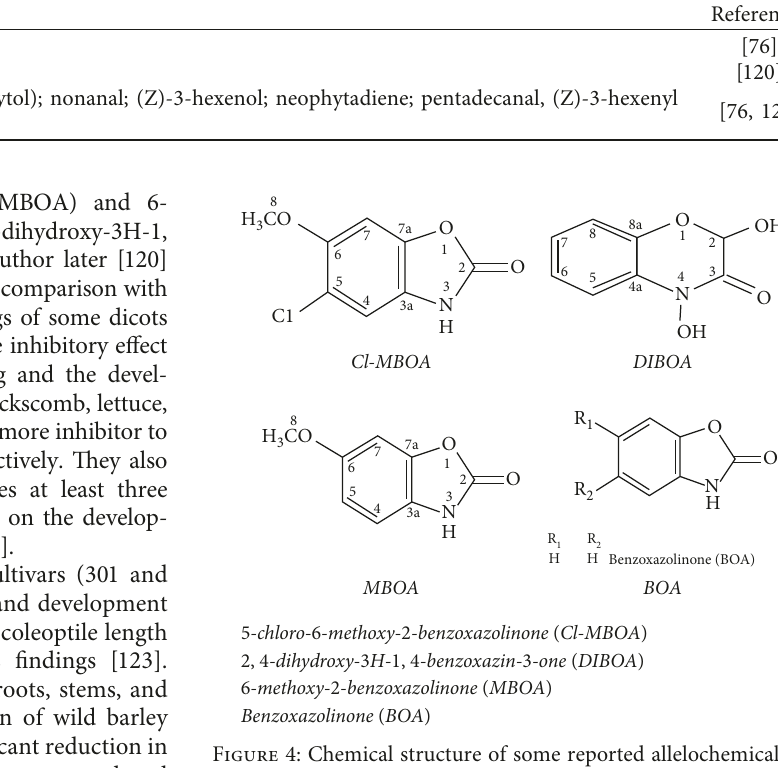
Figure 4: Chemical structure of some reported allelochemicals in corn. (a) 5-Chloro-6-methoxy-2-benzoxazolinone (Cl-MBOA), (b) 2, 4-dihydroxy-3H-1, 4-benzoxazin-3-one (DIBOA), (c) 6- methoxy-2-benzoxazolinone (MBOA), and (d) benzoxazolinone